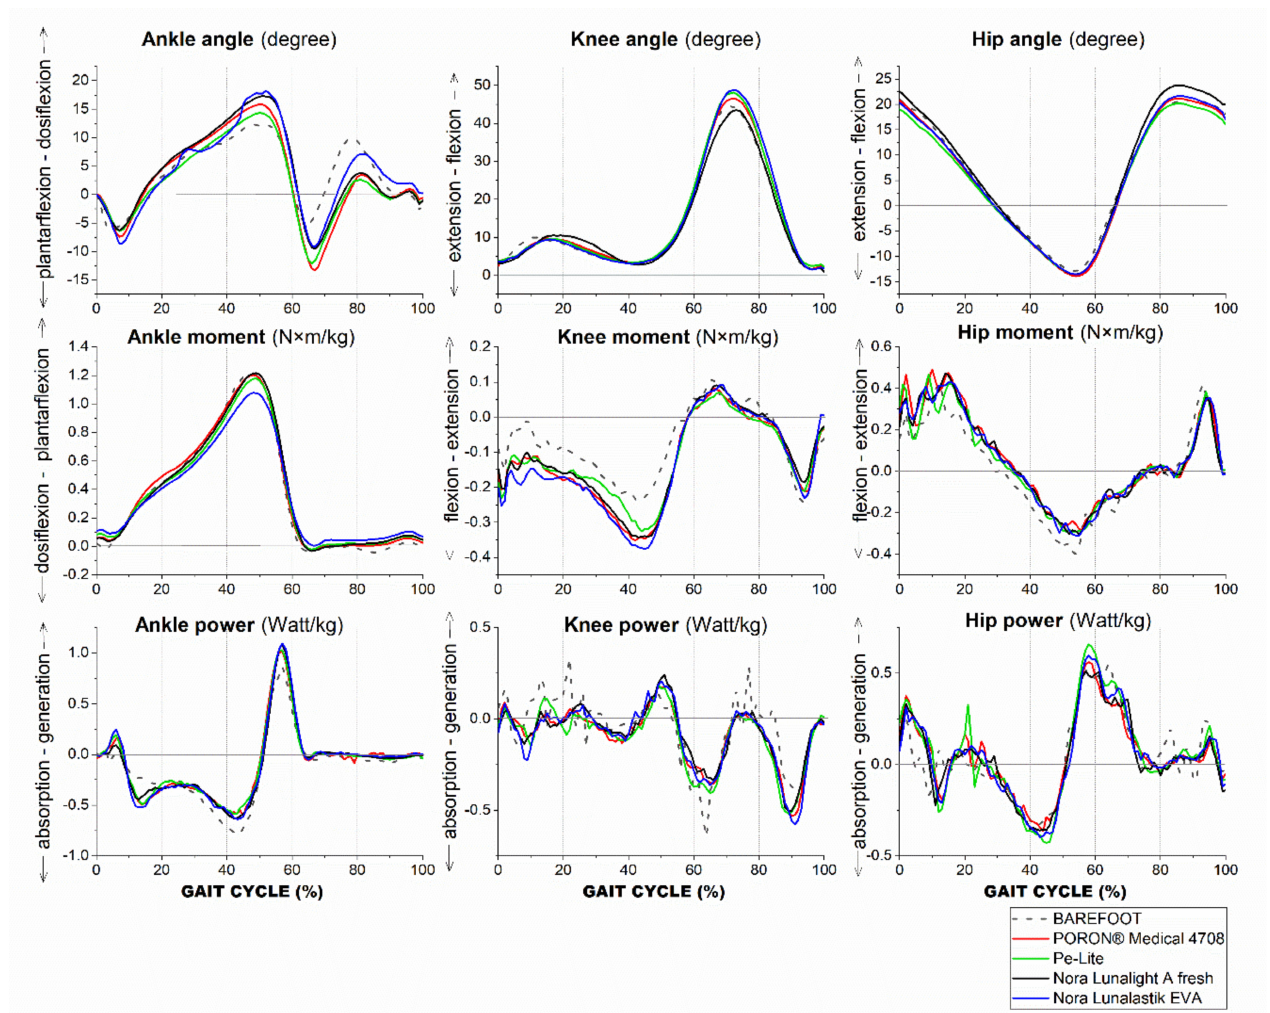
Figure 3. Mean of kinematics and kinetics of the ankle, knee, and hip: 5 conditions during